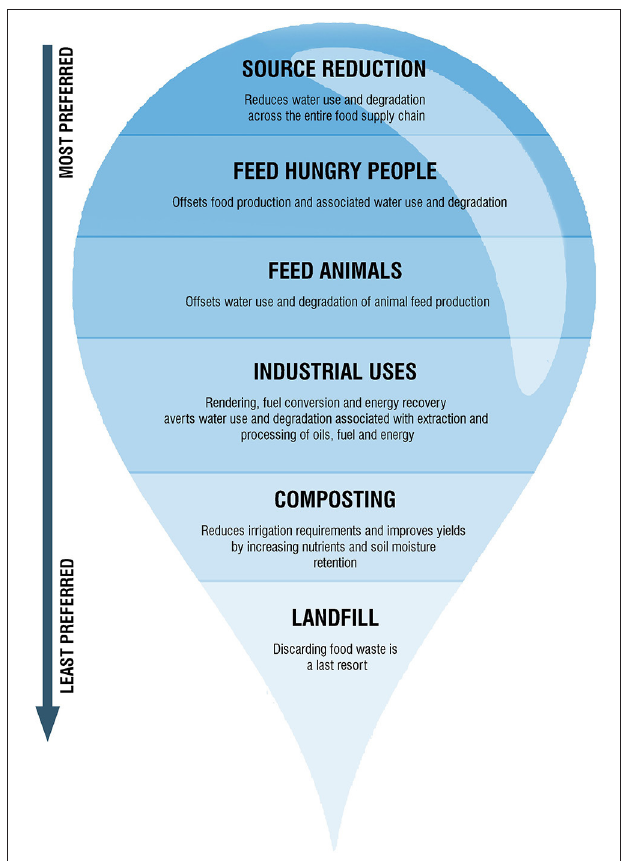
FIGURE 2 | The EPA’s Food Recovery Hierarchy prioritizes measures to reduce food loss and waste based on the benefits they bring to the environment, society, and economy. Here, we highlight each of these strategies’ corresponding impact on water resources. Adapted from the EPA (https://www.epa.gov/sustainable-management-food).